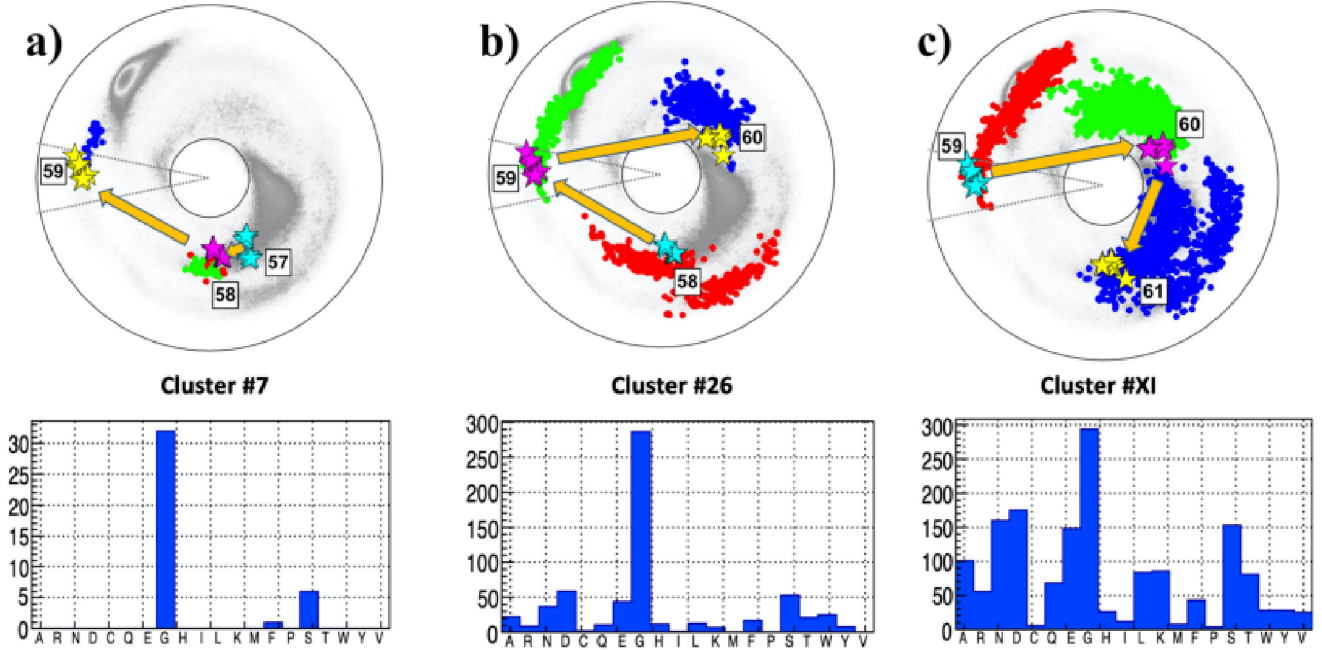
Fig 6. The ( κ i , τ i ) spectrum for i = 57 − 61; this engages sites 55 − 62 along the C α backbone. a) The spectrum for P:(57, 58, 59), in the background of the best matching cluster #7 in [41]. b) The spectrum for A:(58, 59, 60), in the background of the best matching cluster #26 in [41]. c) The spectrum for F:(59, 60, 61), in the background of the best matching cluster #XI in [41]. The most common amino acid in all three clusters is G.